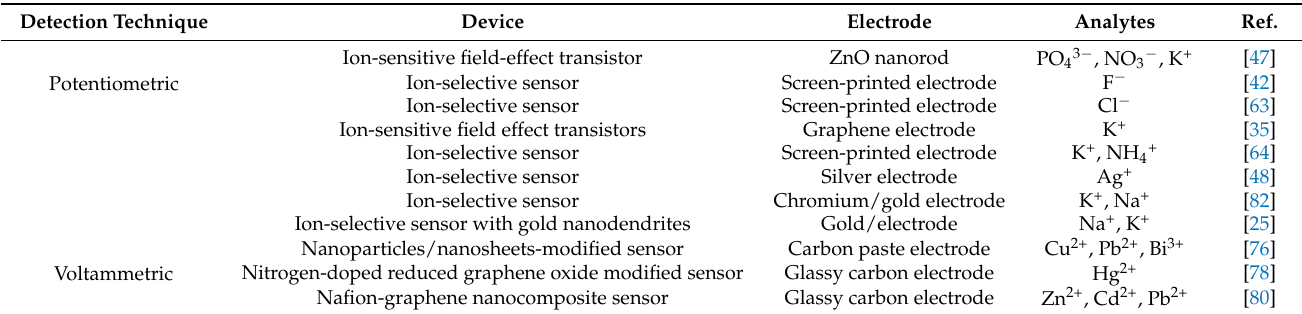
Table 1. Various electrochemical devices for ionic